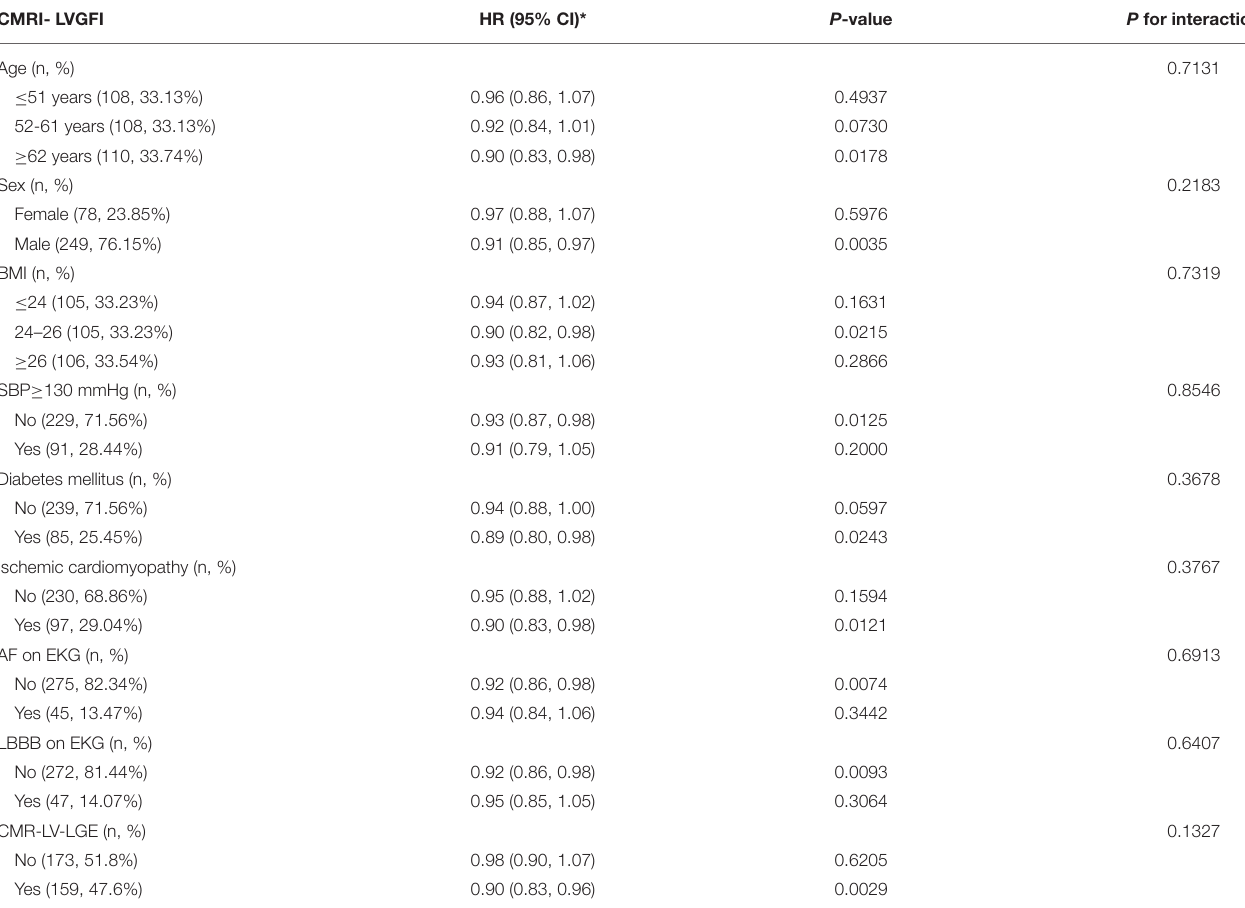
TABLE 4 | Effects of CMR- LVGFI on MACEs in patients with HF in each subgroup by multivariable Cox model within the median follow-up period of 565 days. CMRI- LVGFI HR (95% CI)* P -value P for